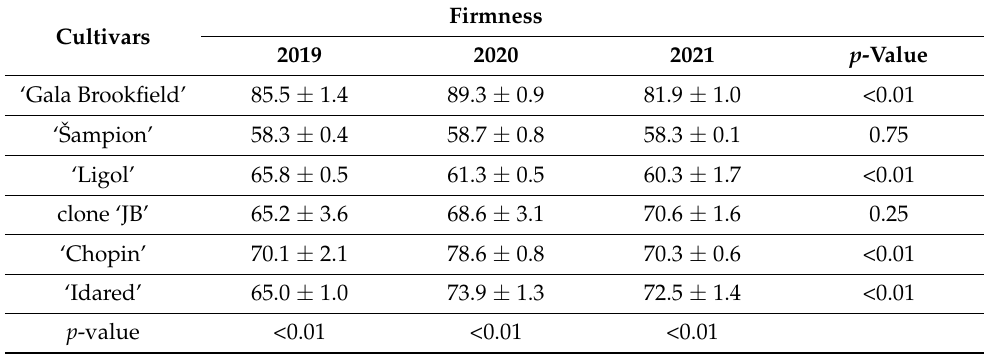
Table 2. The values of firmness (N) for apples depending on cultivars and years of testing. Cultivars